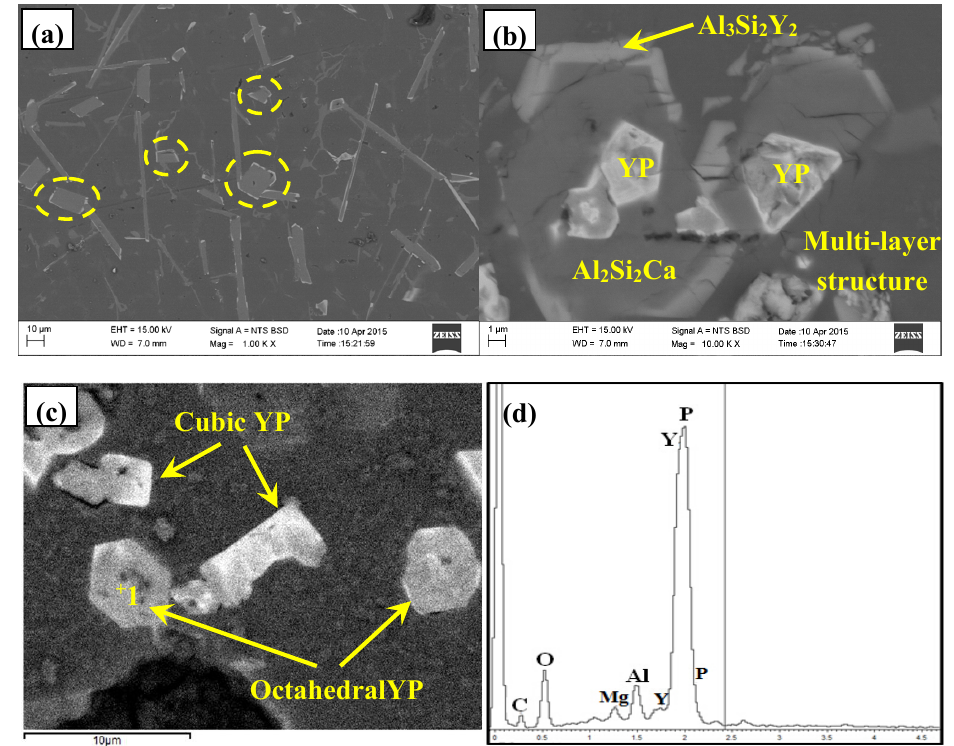
Figure 9. FESEM micrographs and EDS analysis of Al–12Si–2Ca–3Y–1P alloys: ( a – c ) typical